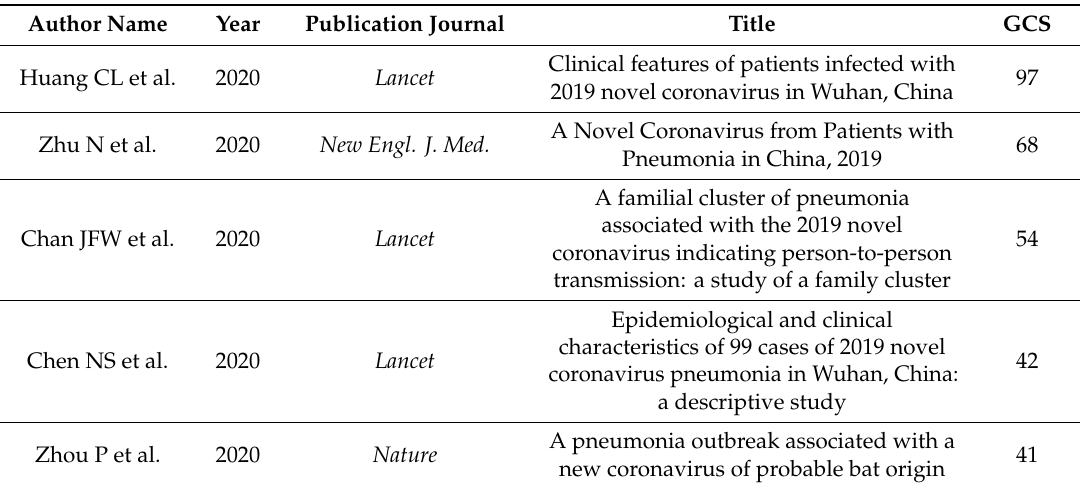
Table 13. Top cited papers with over 40 citations of 2020.